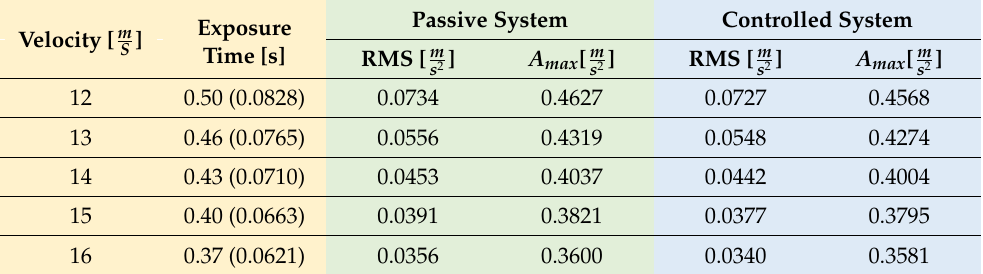
Table 3. The quality indicators of the angular acceleration for pitch